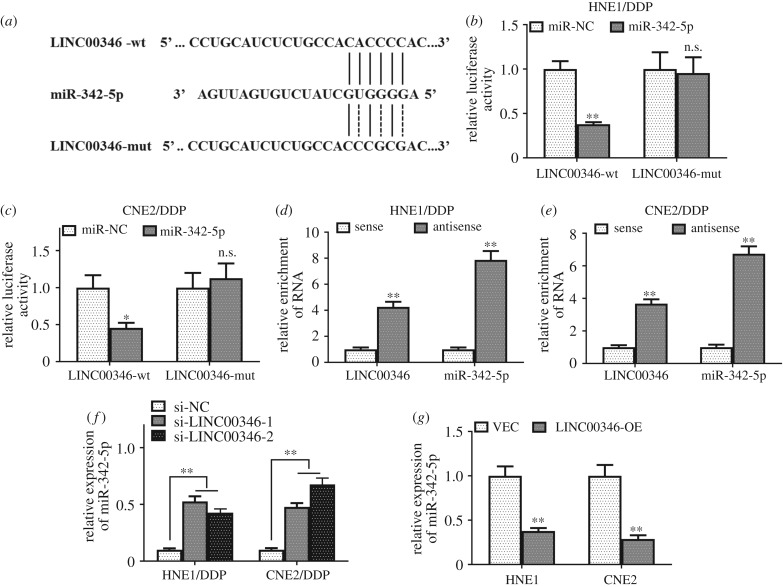
MiR-342-5p is negatively regulated by LINC00346. (a) The predicted binding sites for miR-342-5p on LINC00346 transcript and schematic of luciferase reporter vectors constructed with LINC00346 wild-type (LINC00346-wt) and the miR-342-5p binding-site mutated (LINC00346-mut) sequences. (b,c) The luciferase activities detected in HNE1/DDP and CNE2/DDP cells co-transfected with luciferase reporters and miR-342-5p mimics. (d,e) The relative enrichment of LINC00346 and miR-342-5p detected by biotin pull-down assay. (f) The real-time PCR analysis of miR-342-5p in HNE1/DDP and CNE2/DDP cells transfected with LINC00346 siRNAs or si-NC. (g) The real-time PCR analysis of miR-342-5p in HNE1 and CNE2 cells transfected with LINC00346-OE or VEC. The data show the mean ± s.d. *p < 0.05; **p < 0.01; n.s. = not significant.